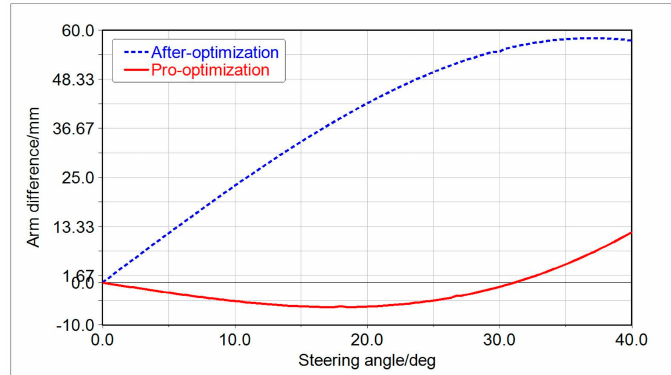
Figure 10. Comparison of arm difference between before and after